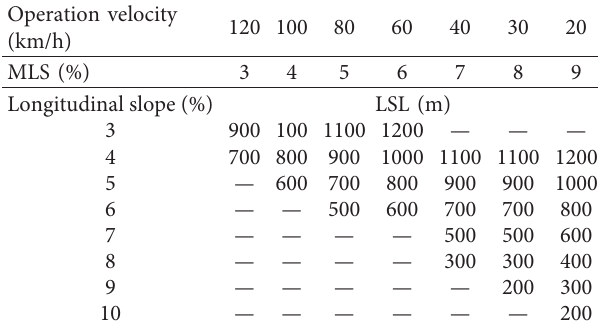
Table 1: MLS and LSL used in current rural road design criteria